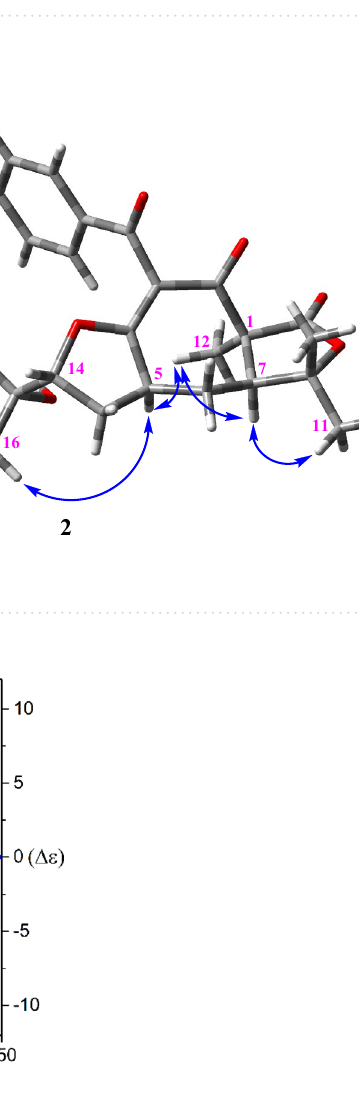
Figure 2. 1 H– 1 H COSY and key HMBC correlations of 1 and 2 .